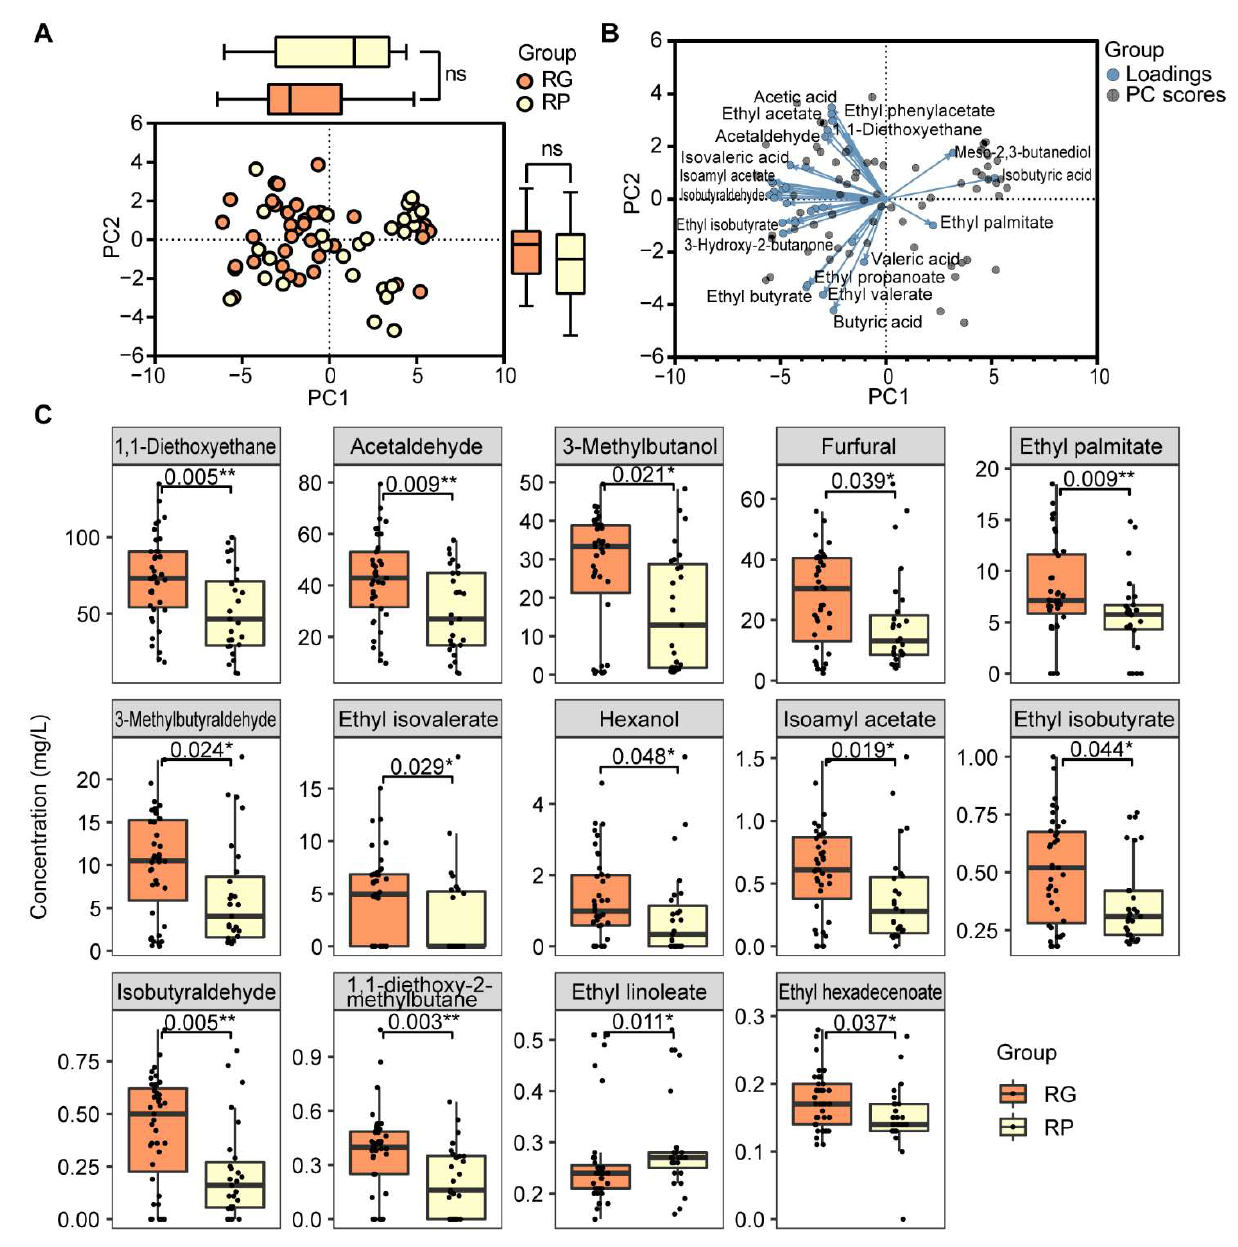
Figure 1. The PCA result and the differential abundances of aroma compounds in the RG group and the RP group. ( A ) PCA result representing the differentiation of the aroma compound abundances between the RG group and RP groups. The orange dots represent samples from the RG group, and the yellow dots represent samples from the RP group. The boxplot at the top represents the PC1 values in two groups, and the boxplot on the right represents the PC2 values in two groups. The orange boxes represent the RG group, and the yellow boxes represent the RP group. ( B ) PCA biplot of the aroma compound abundances between the RG and RP groups. The blue dots represent the compound loadings, and the grey dots represent the samples. ( C ) Boxplots of compounds having statistically different abundances between the RG and RP groups. The orange boxes represent the compound abundances in the RG group, and the yellow boxes represent the compound abundances in the RP group. The significances were calculated via the Kruskal‒Wallis test and a p-value less than 0.05 was considered significant. *: p -value ≤ 0.05, **: p -value ≤ 0.01, ns: not significant.